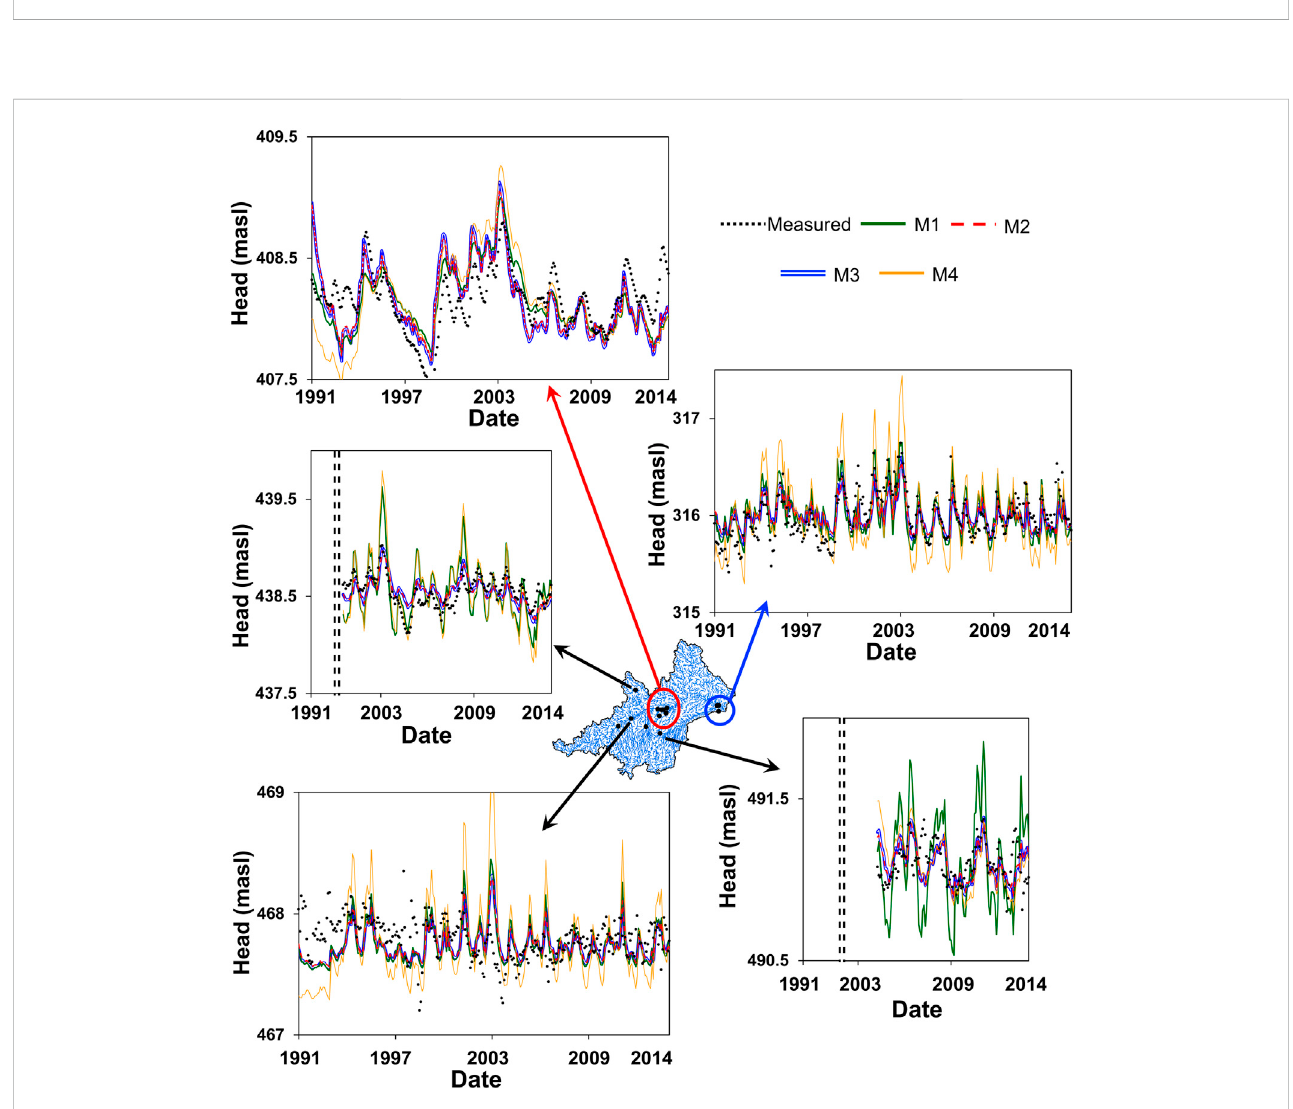
FIGURE 11 Fitting between measured and computed piezometric heads at 5 observation points. Results considering the four calibration methods (M1-M4) are included.